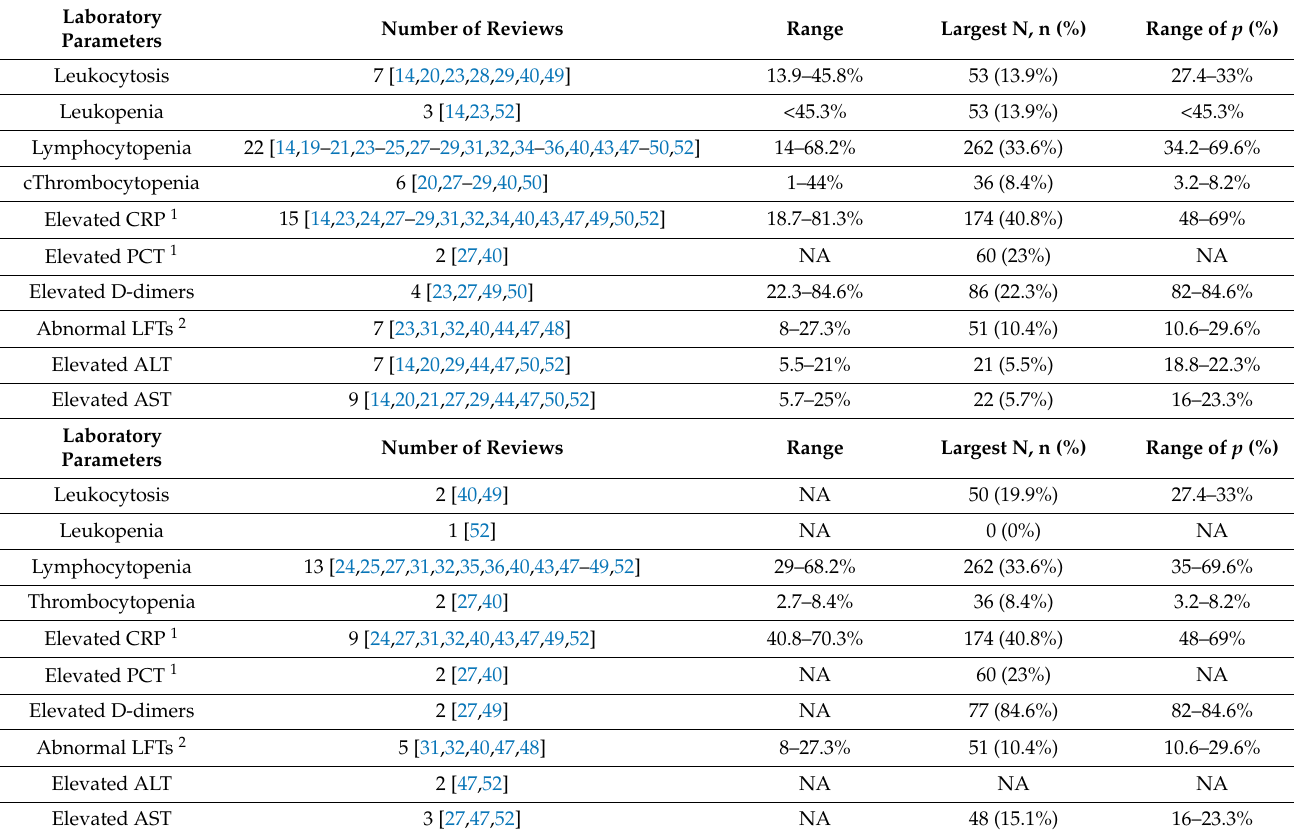
Table 3. Laboratory parameters of infected mothers. Ranges of rates and data extracted from the review with the largest sample are reported. Columns demonstrate analyzed outcomes, number of reviews that provided relevant data on the outcome, range of extractable raw rates, the extracted rate from the largest sample analyzed for the outcome and range of extracted pooled rates. Results are extracted from all eligible systematic reviews. Results are extracted only from moderate and high-quality reviews. Bold denotes differences between the two